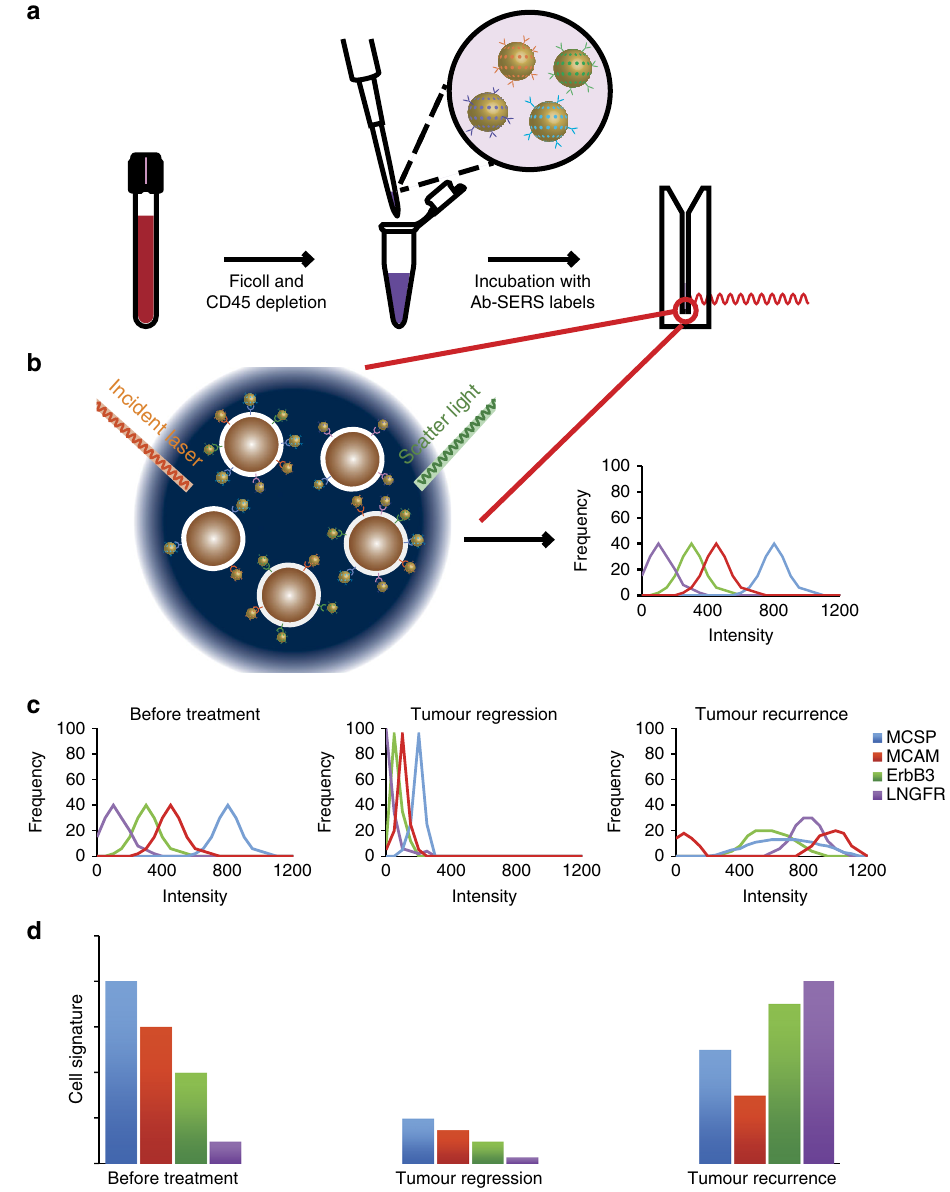
Fig. 1 CTC detection and characterisation with Raman spectroscopy. a , b Schematics of experimental work fl ow: the blood sample taken from a patient is fi rst depleted of RBC and PBMCs by processing over density gradient centrifugation (Ficoll) and subsequent CD45 depletion. Remaining cells are incubated with antibody-conjugated and Raman reporter-coated gold nanoparticles (Ab-SERS labels). The sample is subsequently washed and tested with Raman spectroscopy. To characterise the CTC populations, the Raman intensities are plotted as a frequency distribution curve. This curve represents the sample ’ s range of expression. Higher intensity indicates the presence of more Ab-SERS labels as a result of higher marker expression levels or number of cells. Four melanoma surface marker antibodies (MCSP, MCAM, ErbB3, and LNGFR) with four speci fi c SERS labels can be multiplexed for monitoring the CTC